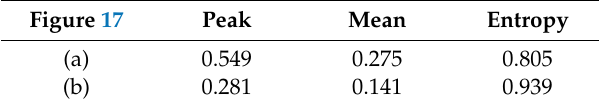
Table 11. Results of MPSM jamming in Figure 17.